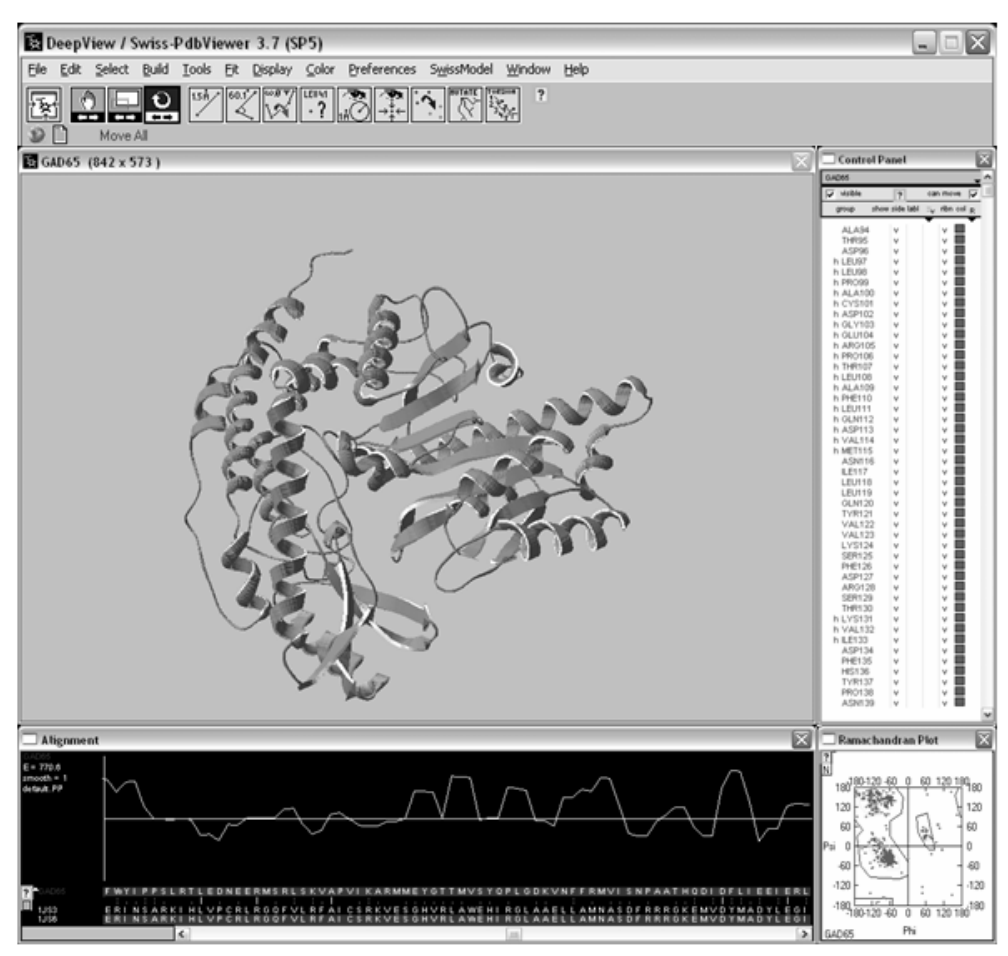
Figure 1: The Swiss-Pdb Viewer emphasis several windows. The main window (top) enables the interactive manipulation of the protein structure in the display window (middle). In the control panel window (right side) individual amino acid residues can be selected for display. The alignment window (bottom) displays the protein sequence. The viewer is used for preparing the homology modelling. After the modelling process, the result of homology modelling is visualized and analyzed. The predicted structure is superimposed on its template struc- tures. Adjustments and improvements of the target template sequence alignment can be made. The mean force potential energy curve (bottom) depicts how well each residue is embedded in its surrounding. The Ramachandran map (bottom, right) shows how well the values of the dihedral angles agree with the values of allowed conformations for protein